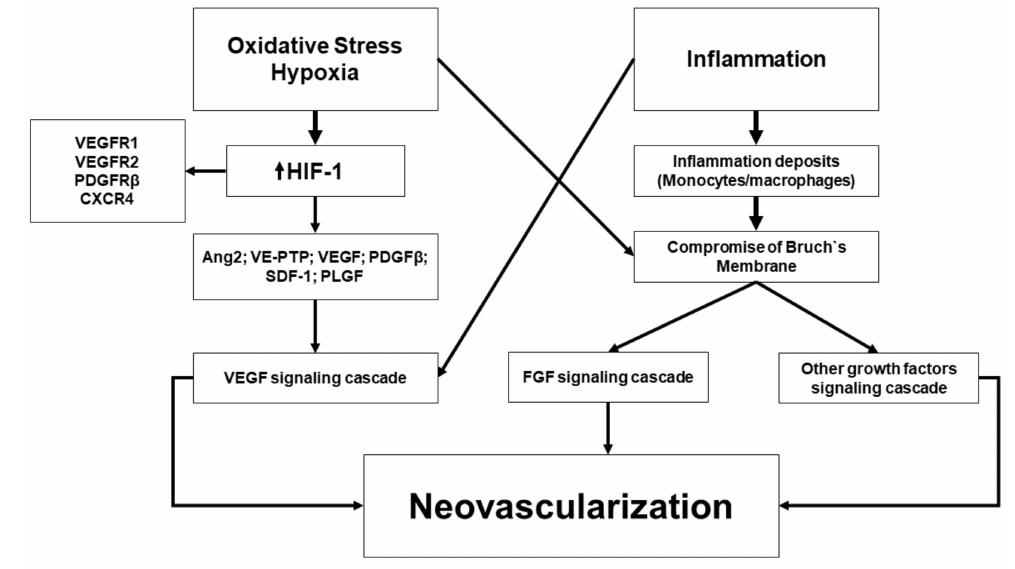
Figure 1. Overview of the pathophysiological leading to choroidal neovascularization. Adapted from Campochiaro [34] and Anderson et al.